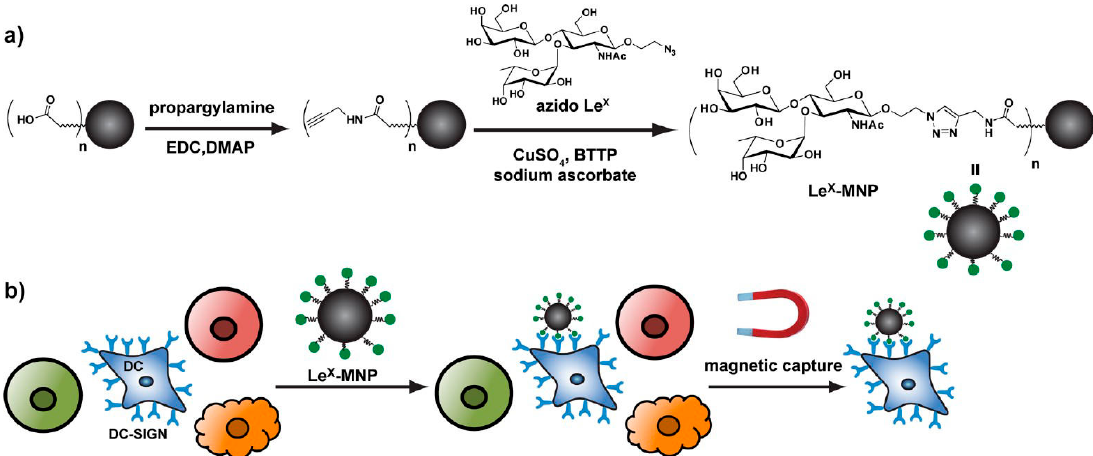
Figure 10. ( a ) synthesis of Le X -coated MNPs and ( b ) selective capturing of DCs from a cell population by functionalized MNPs. Reproduced with permission from [111]. Copyright American Chemical Society, 2012.